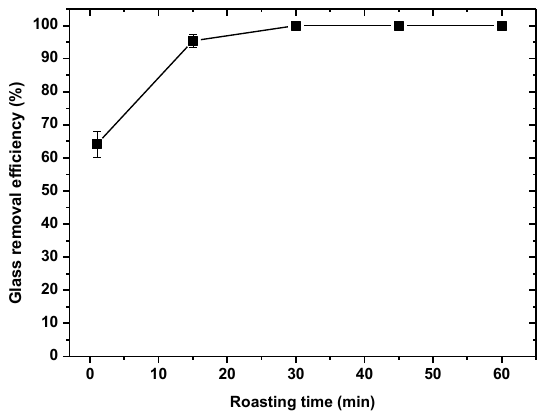
Figure 6. Effect of roasting time on glass removal efficiency (experimental conditions: abrasive – glass polishing waste: approximately 1 g; roasting temperature: 450 °C; mass ratio of polishing waste to NaOH: 1:1; water leaching pH: 3; leaching temperature: 25 °C, liquid – solid ratio: 200 mL/g).